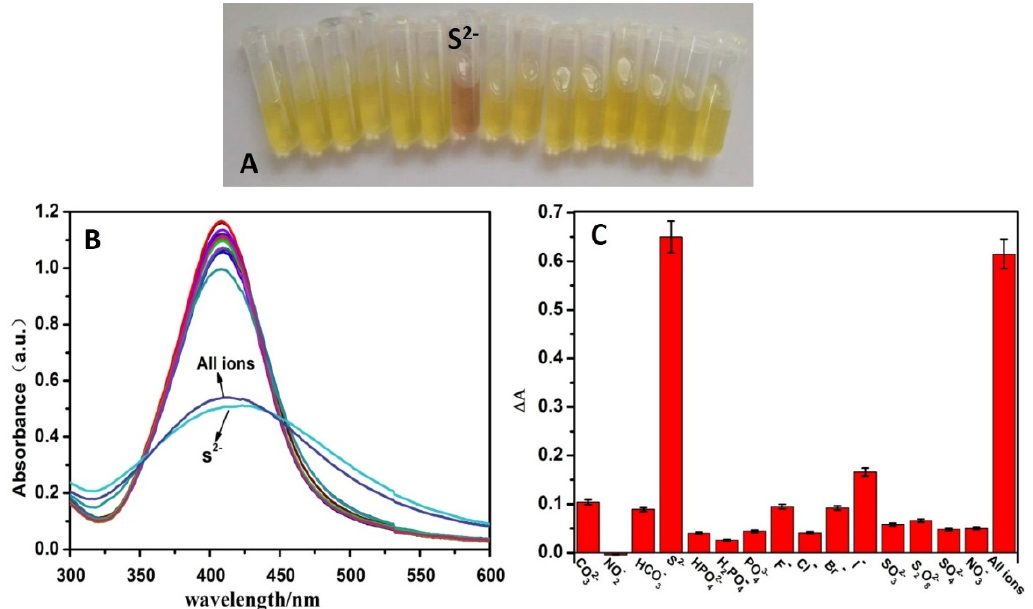
Figure 10. ( A ) The color changes picture, ( B ) UV–VIS absorption spectra, and ( C ) Δ A of the proposed sensing system in the presence of 15 kinds various negative ions and mixed all ions (the concentrations of all negative ions are 50 μ M).